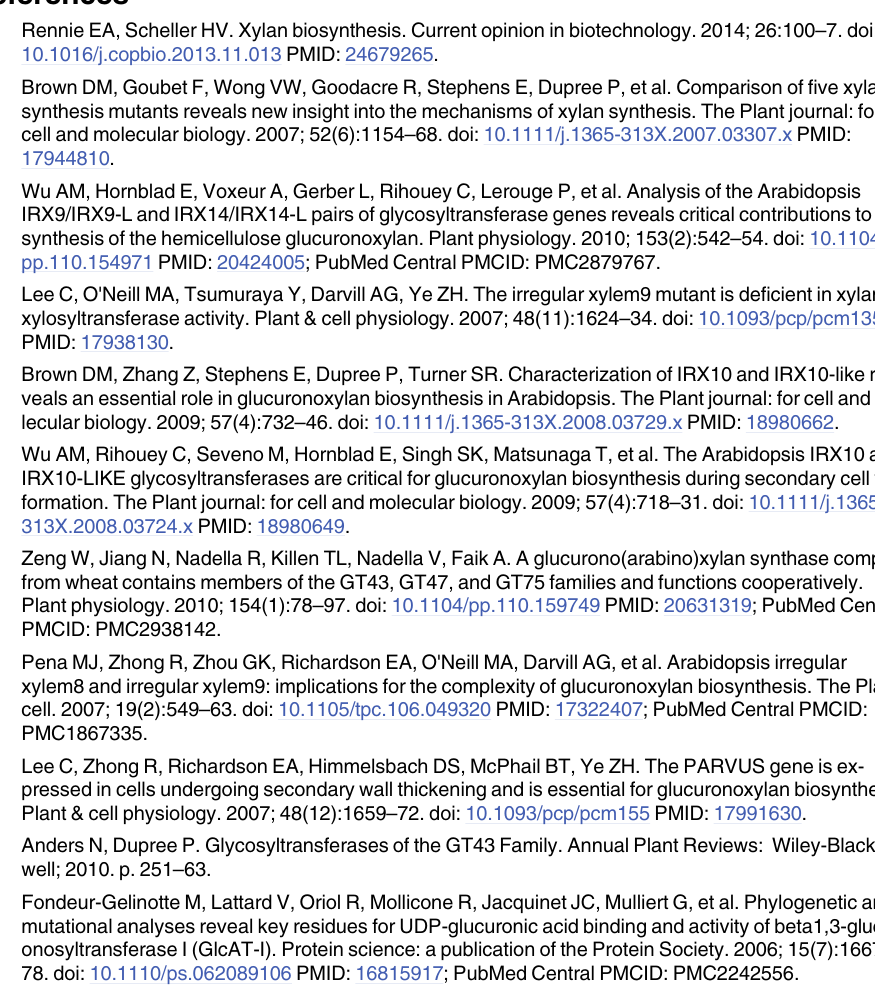
S4 Table. 54 assembled transcripts that hit their best PlantCAZyme match with E-value < 1e- 10; Clade column is based on Fig 2; peptides having at least 3 motifs are shown in yellow background. S5 Table. GT43 genes in seven land